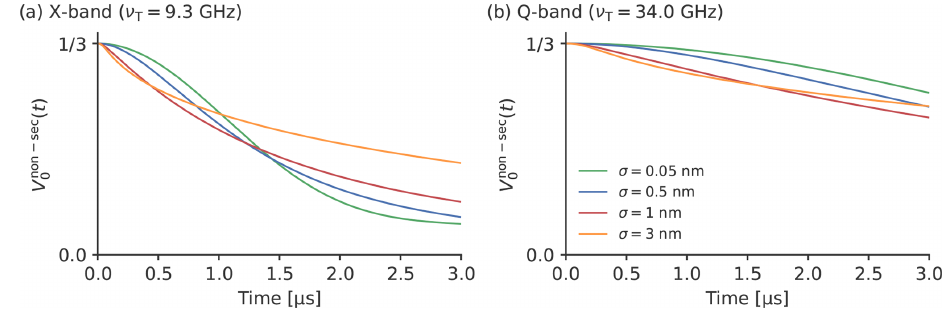
( t ) for TPP in the (a) X-band and (b) Q-band. The 0